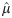
Comparison of the susceptibility of h-index (left) and μ (right) to manipulation.
Bottom panel: For each researcher in the database, we add publications with self-citations until we reach the desired value of index (see main text for details). The dashed black, dotted-dashed black and dotted white lines indicate the number of publications required to increase the index value by 10%, 50% and 100%, respectively. The solid diagonal black line indicates when the current value of μ^ is equal to the manipulated μ^. The dark blue vertical line represents the average value of the indicator amongst all researchers in our database. Top panel: Distributions of current h-index (left) and μ^ (right) for all researchers in the database.